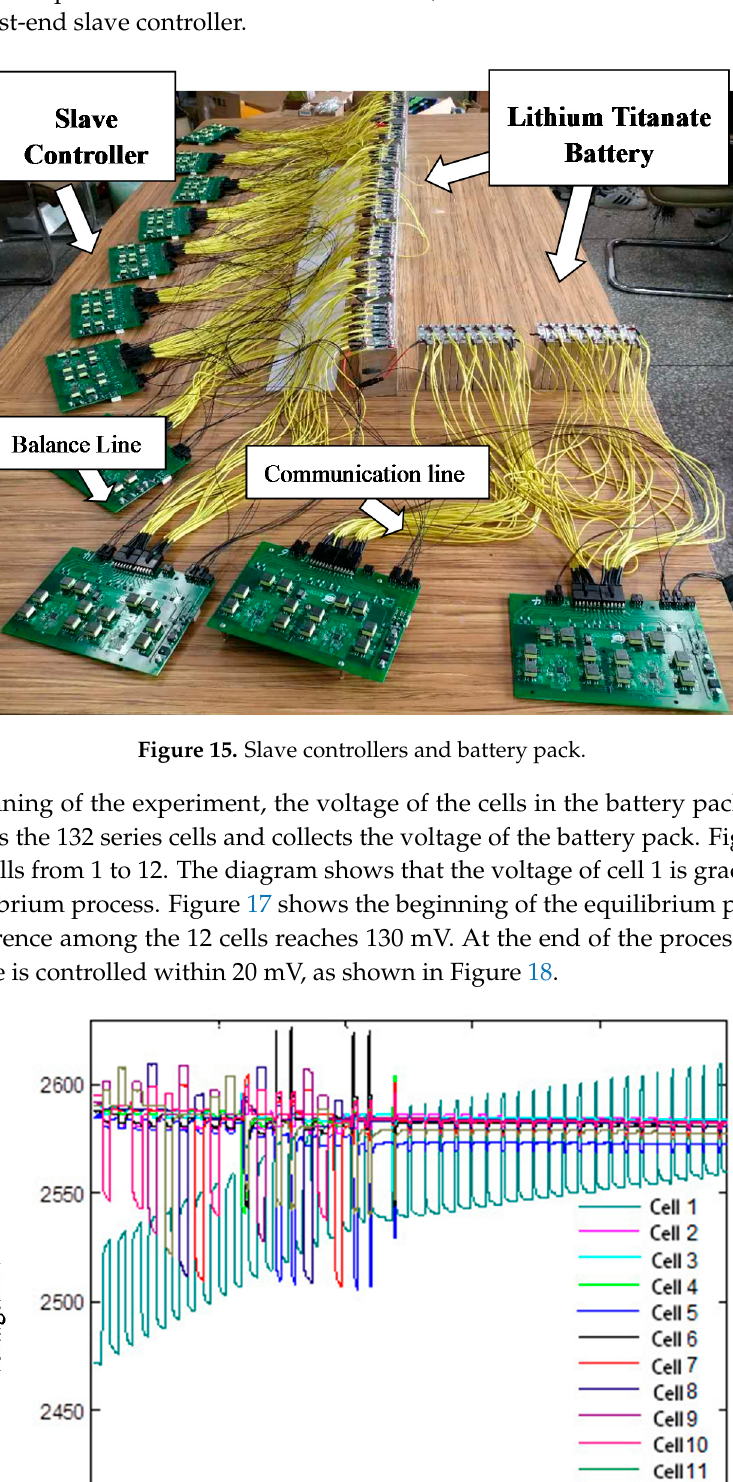
Figure 14. Experimental communication control process.